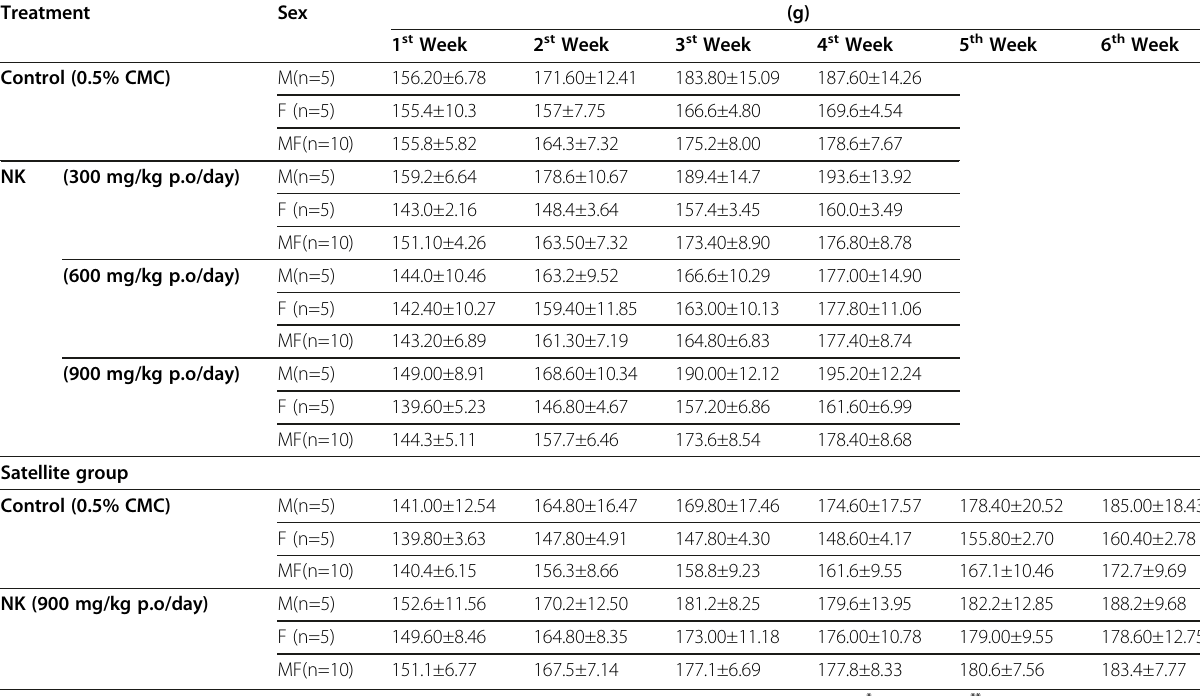
Table 4 Effect of Nuna kadugu on body weight gain in experimental rats - repeated oral toxicity study Treatment Control (0.5% CMC)